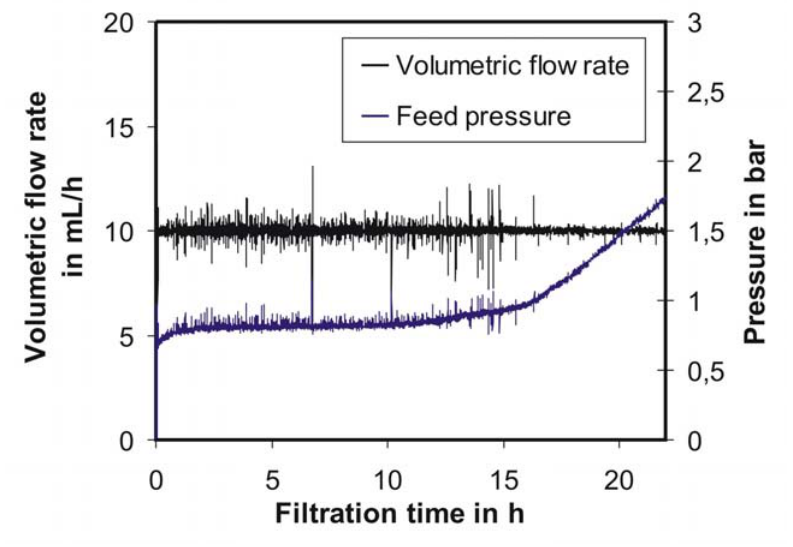
Figure 3. Volumetric flow rate and feed pressure development over time, c T = 40 °C [4].